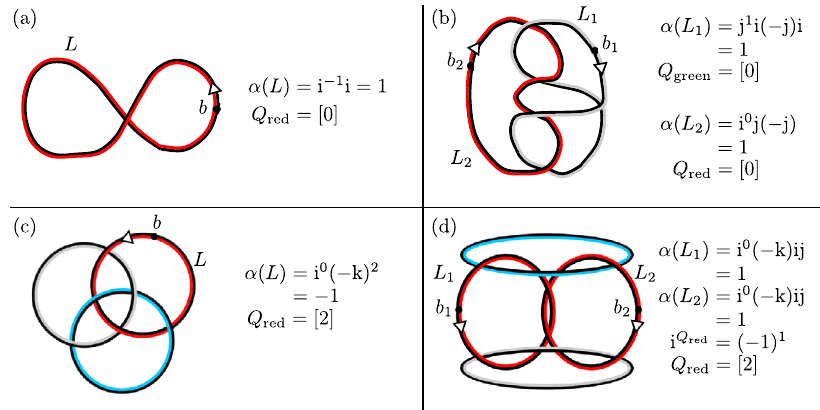
Fig. 8 Examples of α -invariants and colored invariants Q c of Q 8 -colored links. a – d Loops of interest L k and the corresponding basepoints b k together with their α and Q c invariants. According to the orientation convention, a loop is oriented in such a way, that when moving from the basepoint according to the orientation, the black color of the bicoloring is on the